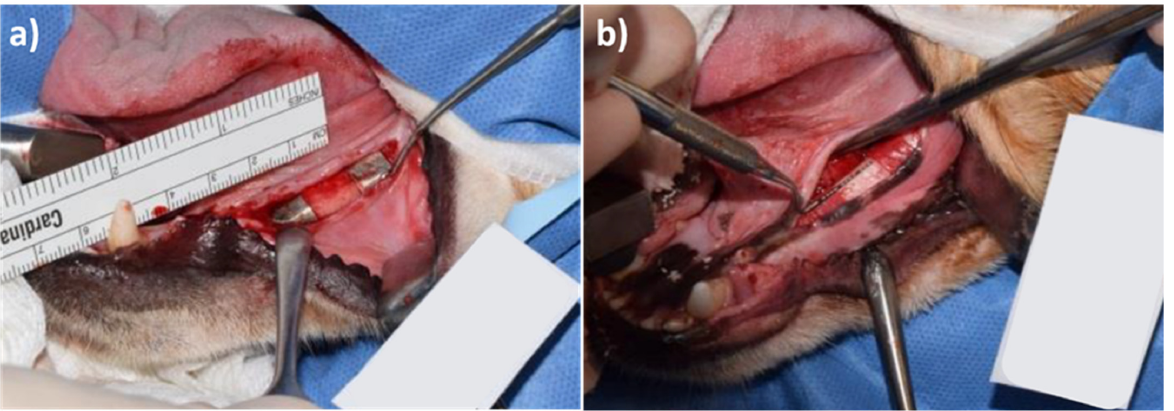
Figure 5. Surgical placement of ( a ) magnesium membrane and ( b ) collagen membrane in a GBR model in the lower left jaw of beagle dogs. In both images, two treatment sites are visible.